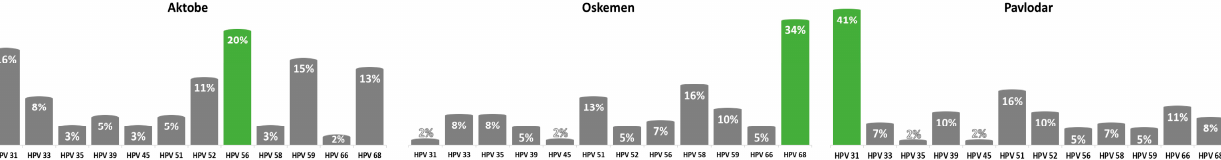
Figure 1. Geographical distribution of HR-HPV types other than HPV-16 and HPV-18 across Kazakhstan .